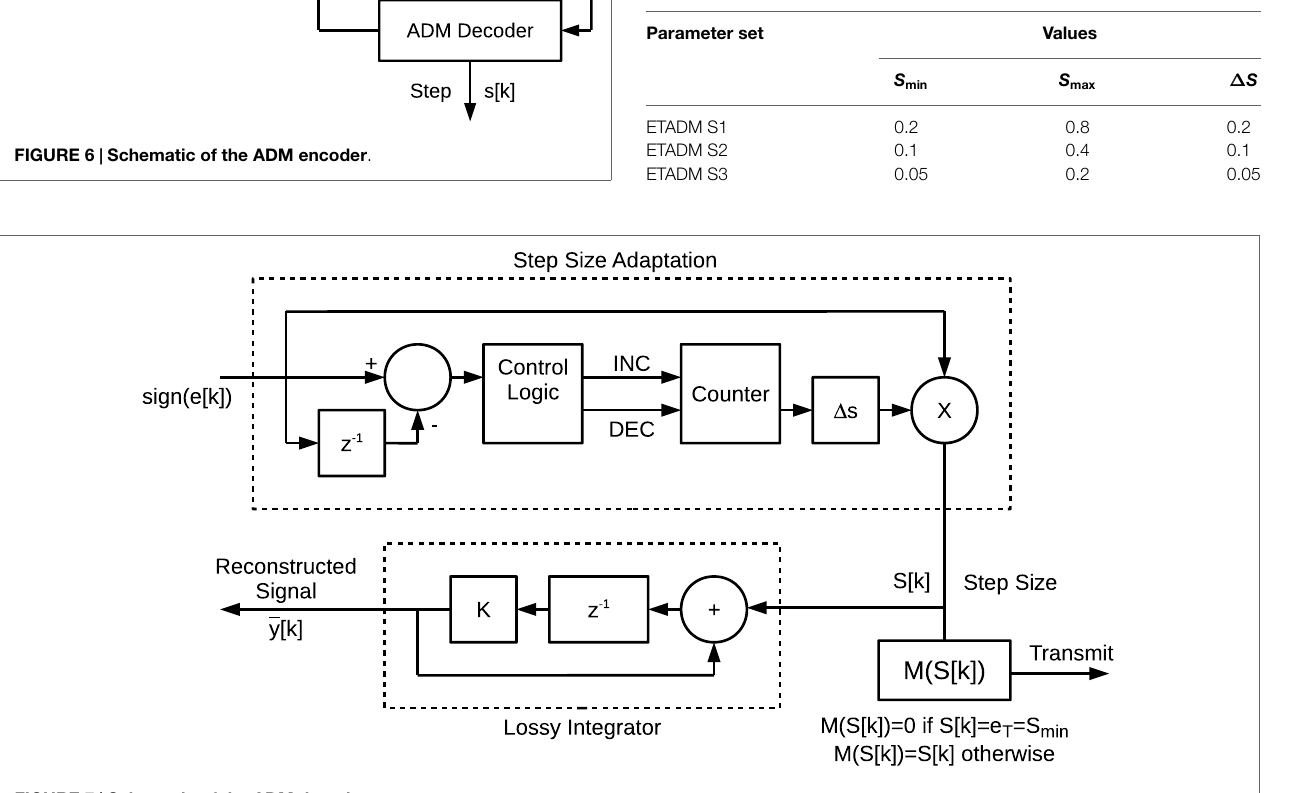
TABLE 1 | Encoding scheme parameters .